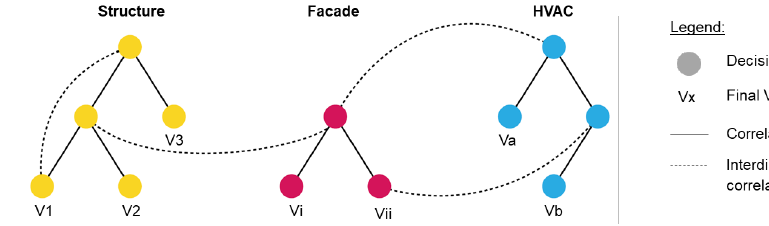
Figure 1. Combining discipline-specific decision trees.